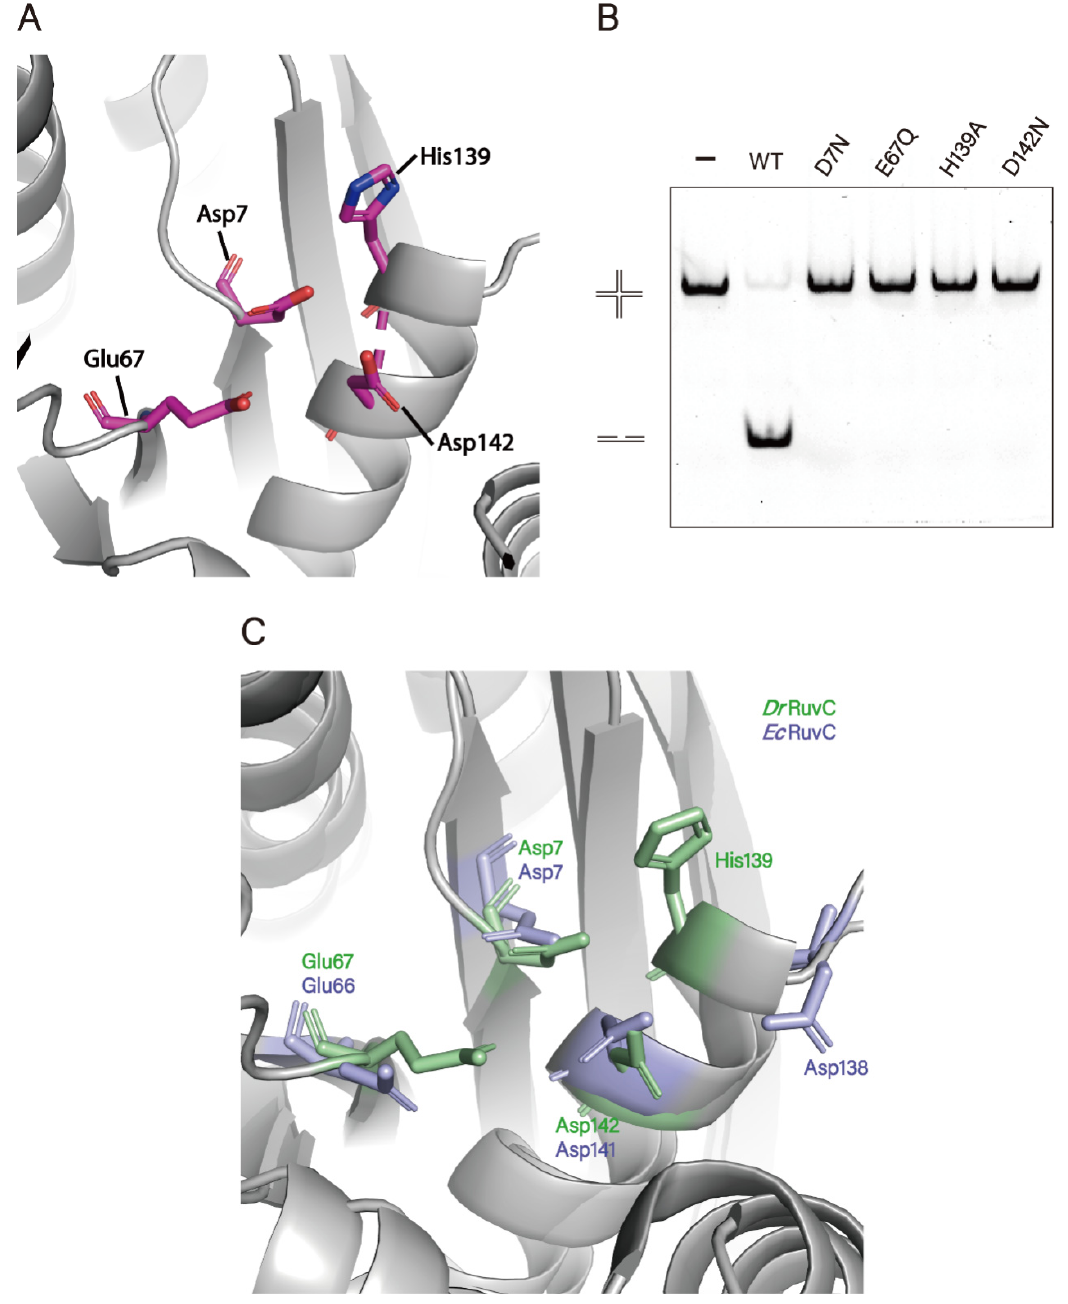
Figure 5. The active sites of Dr RuvC. ( A ) The active site of Dr RuvC. Dr RuvC is shown in grey and the catalytic residues are highlighted in magenta sticks. ( B ) Holliday junction cleavage assay of Dr RuvC wild type (WT) or various mutants. ( C ) Superposition of the catalytic residues from Dr RuvC (green) and Ec RuvC (blue).